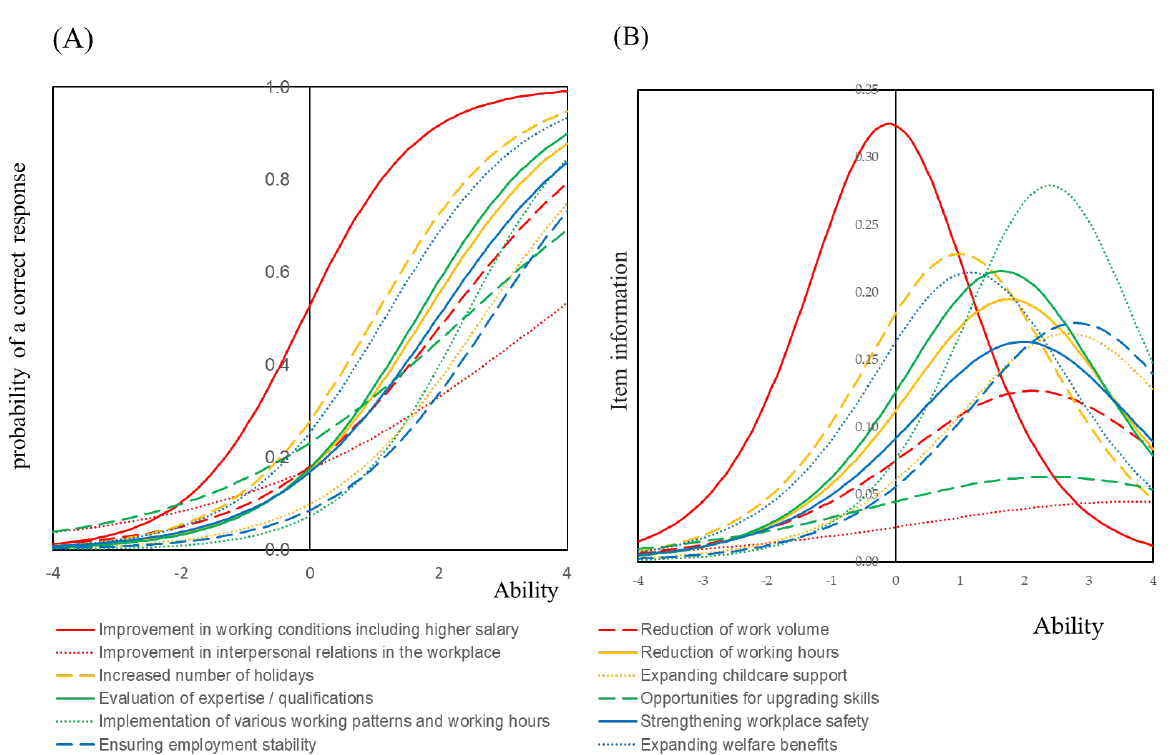
Figure 1. Item response curve and item information curve of Improvement in working